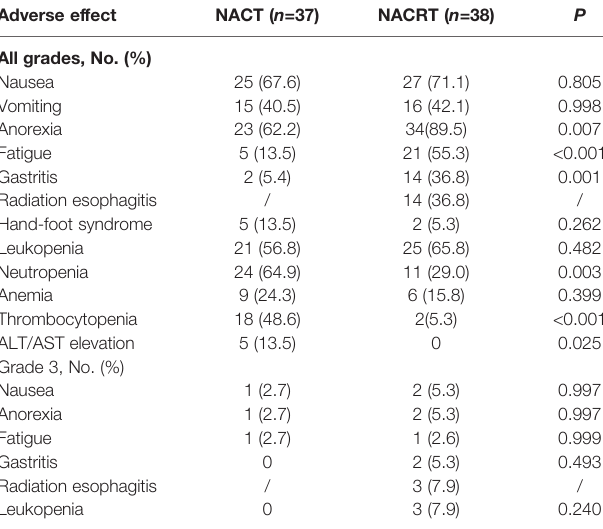
TABLE 1 | Patient characteristics. TABLE 2 | Overall toxicities associated with neoadjuvant